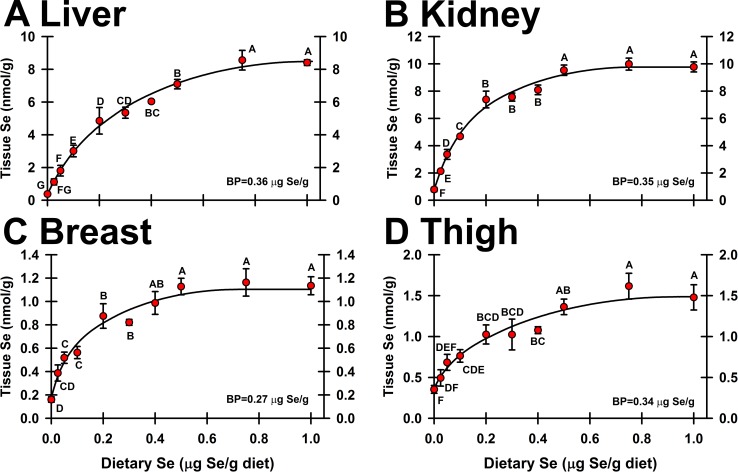
Effect of dietary Se on tissue Se concentration.Se concentration in liver (A), kidney (B), breast (C), and thigh (D), expressed as μg Se/g wet tissue. Values are means ± SEM (n = 3/treatment). Means without a common letter are significantly different (p<0.05). Overall levels of significance, as determined by ANOVA, are given in Table 1. Se response curve breakpoints (BP) are calculated as described in text.